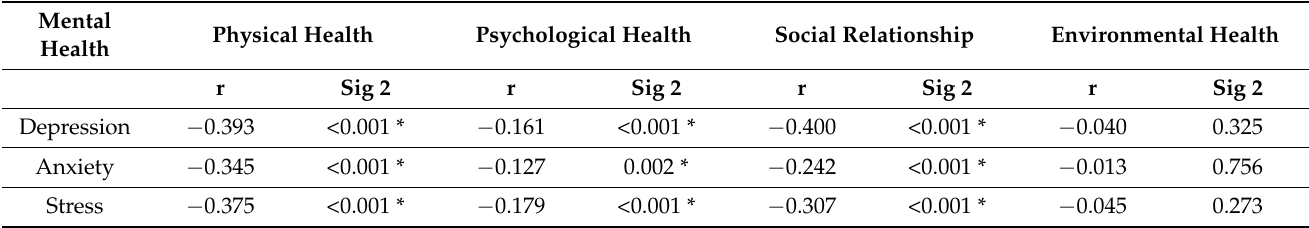
Table 9. Correlation test to determine the relationship between MH and